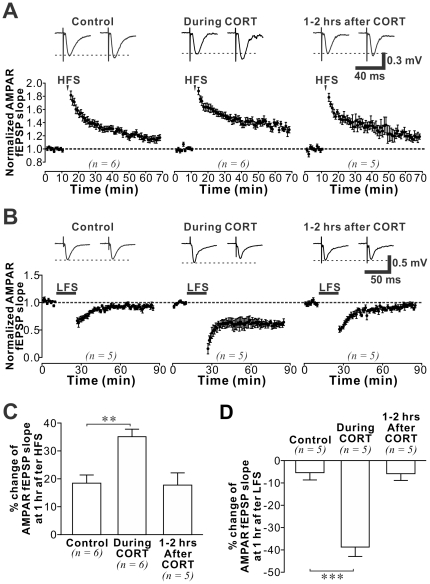
CORT-induced time-dependent regulation of bidirectional plasticity.(A) Plots of AMPAR-mediated fEPSP slope against time from data recorded in control, during CORT, and 1-2 hours after CORT. LTP was induced by high frequency stimulation (HFS; 100 Hz, 100 pulses). Representative traces were obtained before (left) and 55 min after HFS (right). (B) Plots of AMPAR-mediated fEPSP slope against time from data recorded in control, during CORT, and 1–2 hours after CORT treatment. LTD was induced by low frequency stimulation (LFS; 1 Hz, 900 pulses). (C) Histogram summarizes the percentage change of AMPAR-mediated fEPSP slope in control and different CORT-treated groups at 55 min after HFS or LFS. Note that the facilitation of LTP and LTD caused by CORT was abolished 1–2 hours after CORT treatment. Post-hoc Fisher's test after ANOVA: ** p<0.01, *** p<0.001.